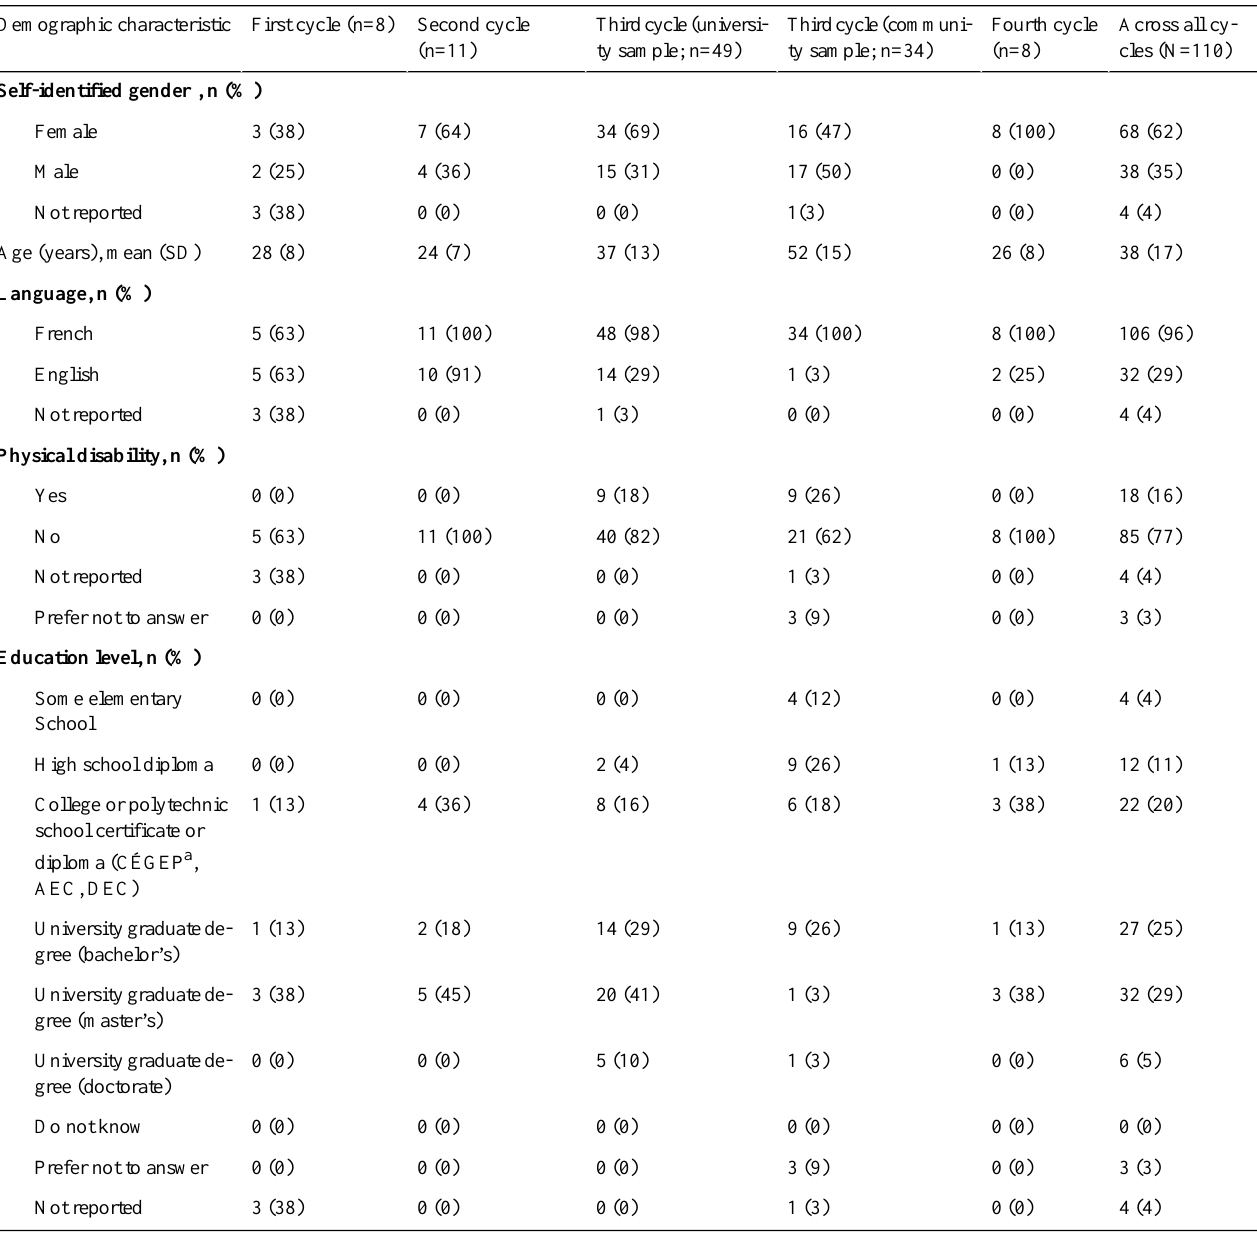
Table 2. Sociodemographics of each cycle.